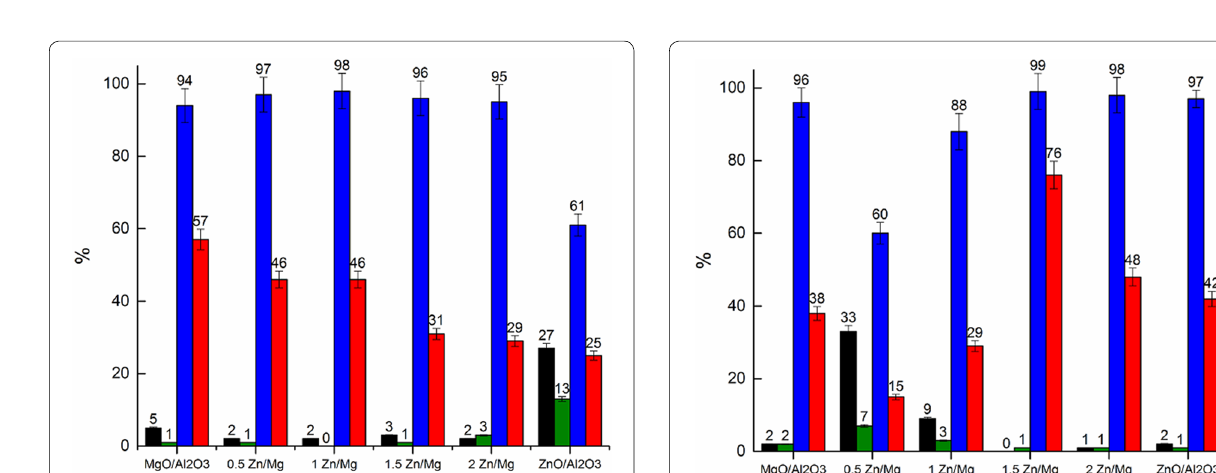
200); c Zn mapping ×